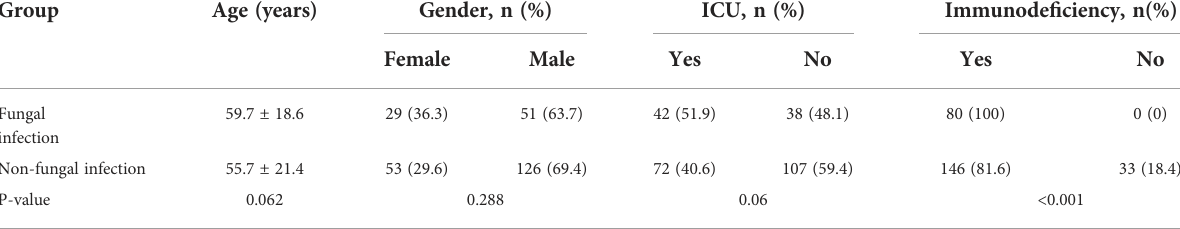
TABLE 2 Demographic characteristics of study participants with fungal or non-fungal infections of the respiratory tract. Group